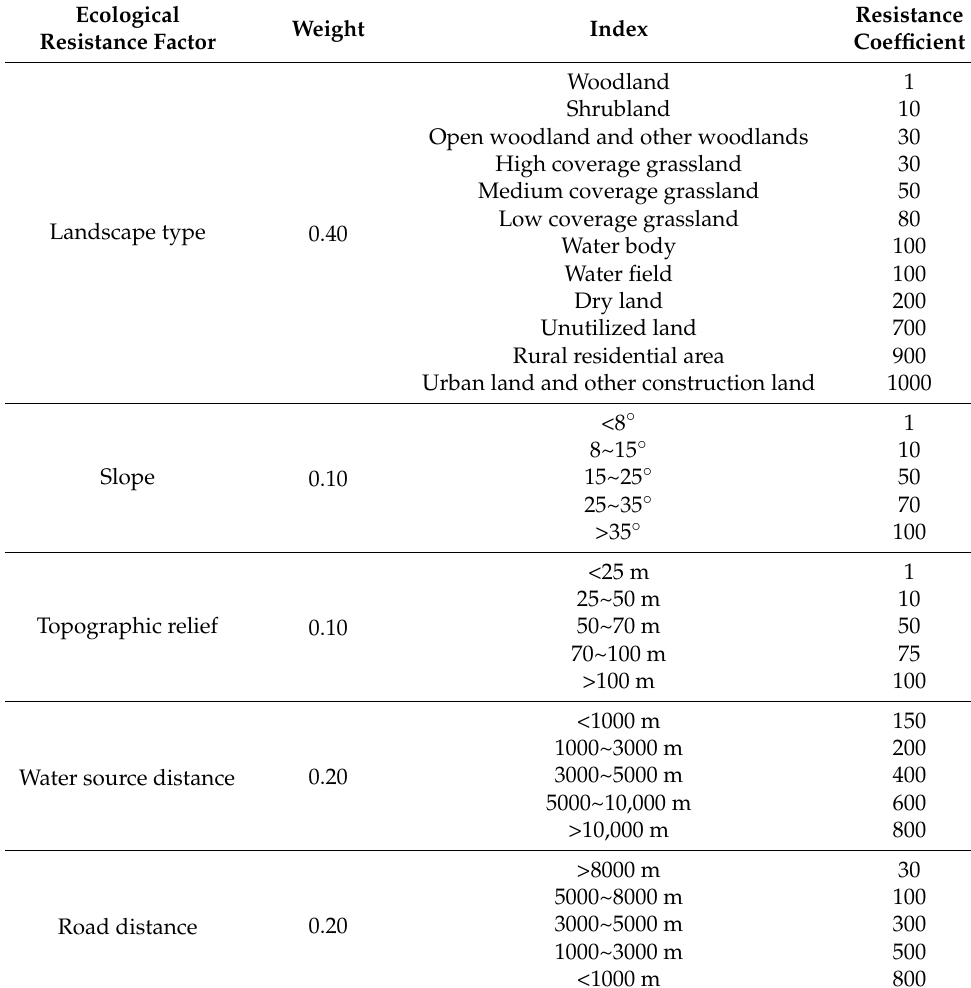
Table 5. Comprehensive ecological resistance surface weights and resistance coefficients.